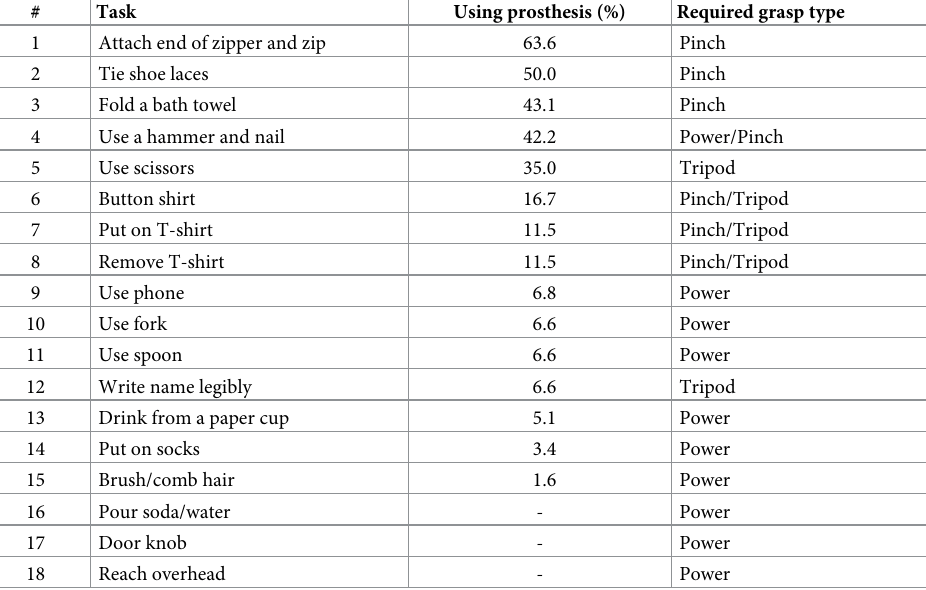
Table 1. AM-ULA items [26] and the percentage the activity is performed using the prosthetic hand with unilat- eral amputees